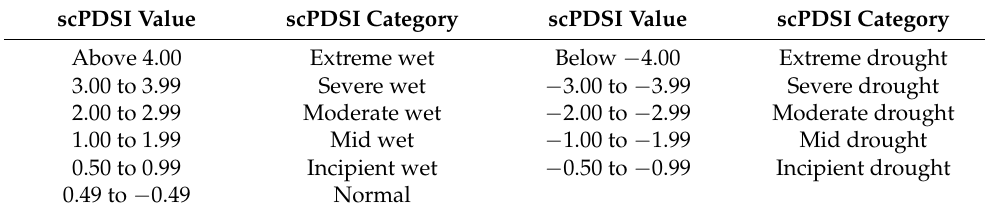
Table 1. Classification of the scPDSI Values.